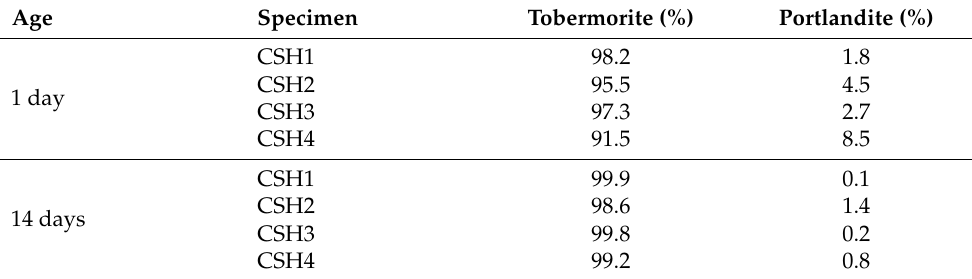
Table 2. The refined mass percentage of crystalline phases.